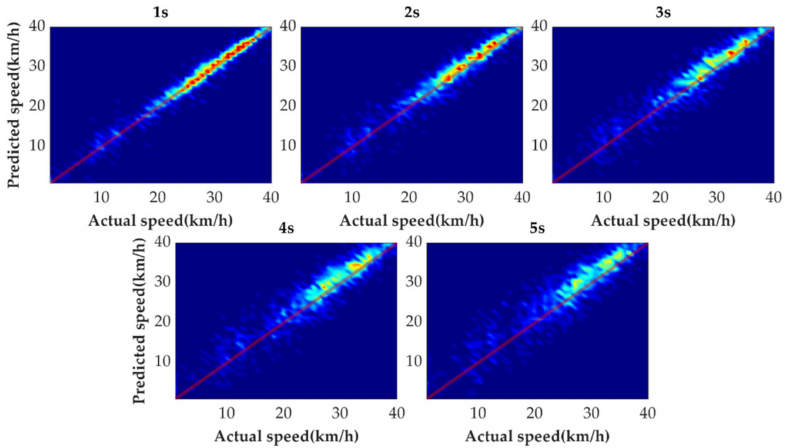
Figure 11. Heat map display of the predicted results of MCMC.